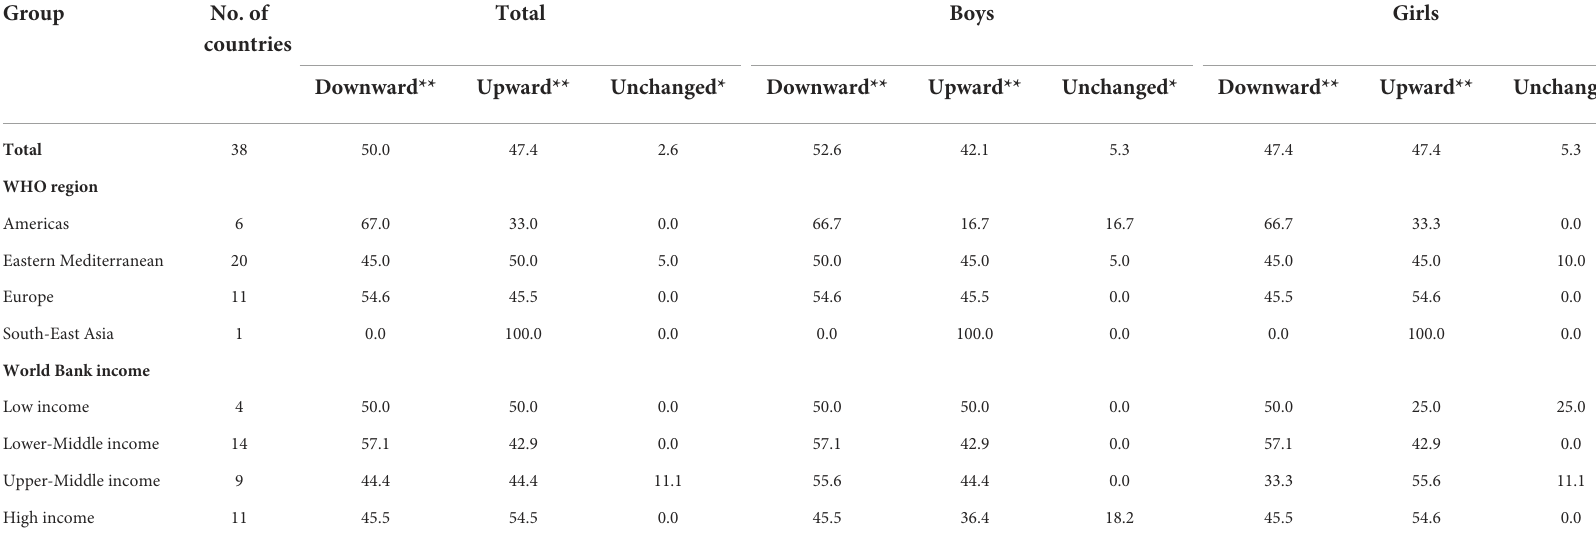
TABLE 3 Proportions of countries with upward, downward, and unchanged trends in waterpipe smoking (on ≥ 1 day during the past 30 days) among adolescents aged 12–16 years from 2000 to 2019. Group No. of Total Boys Girls countries Downward** Upward** Unchanged* Downward** Upward** Unchanged* Downward** Upward**